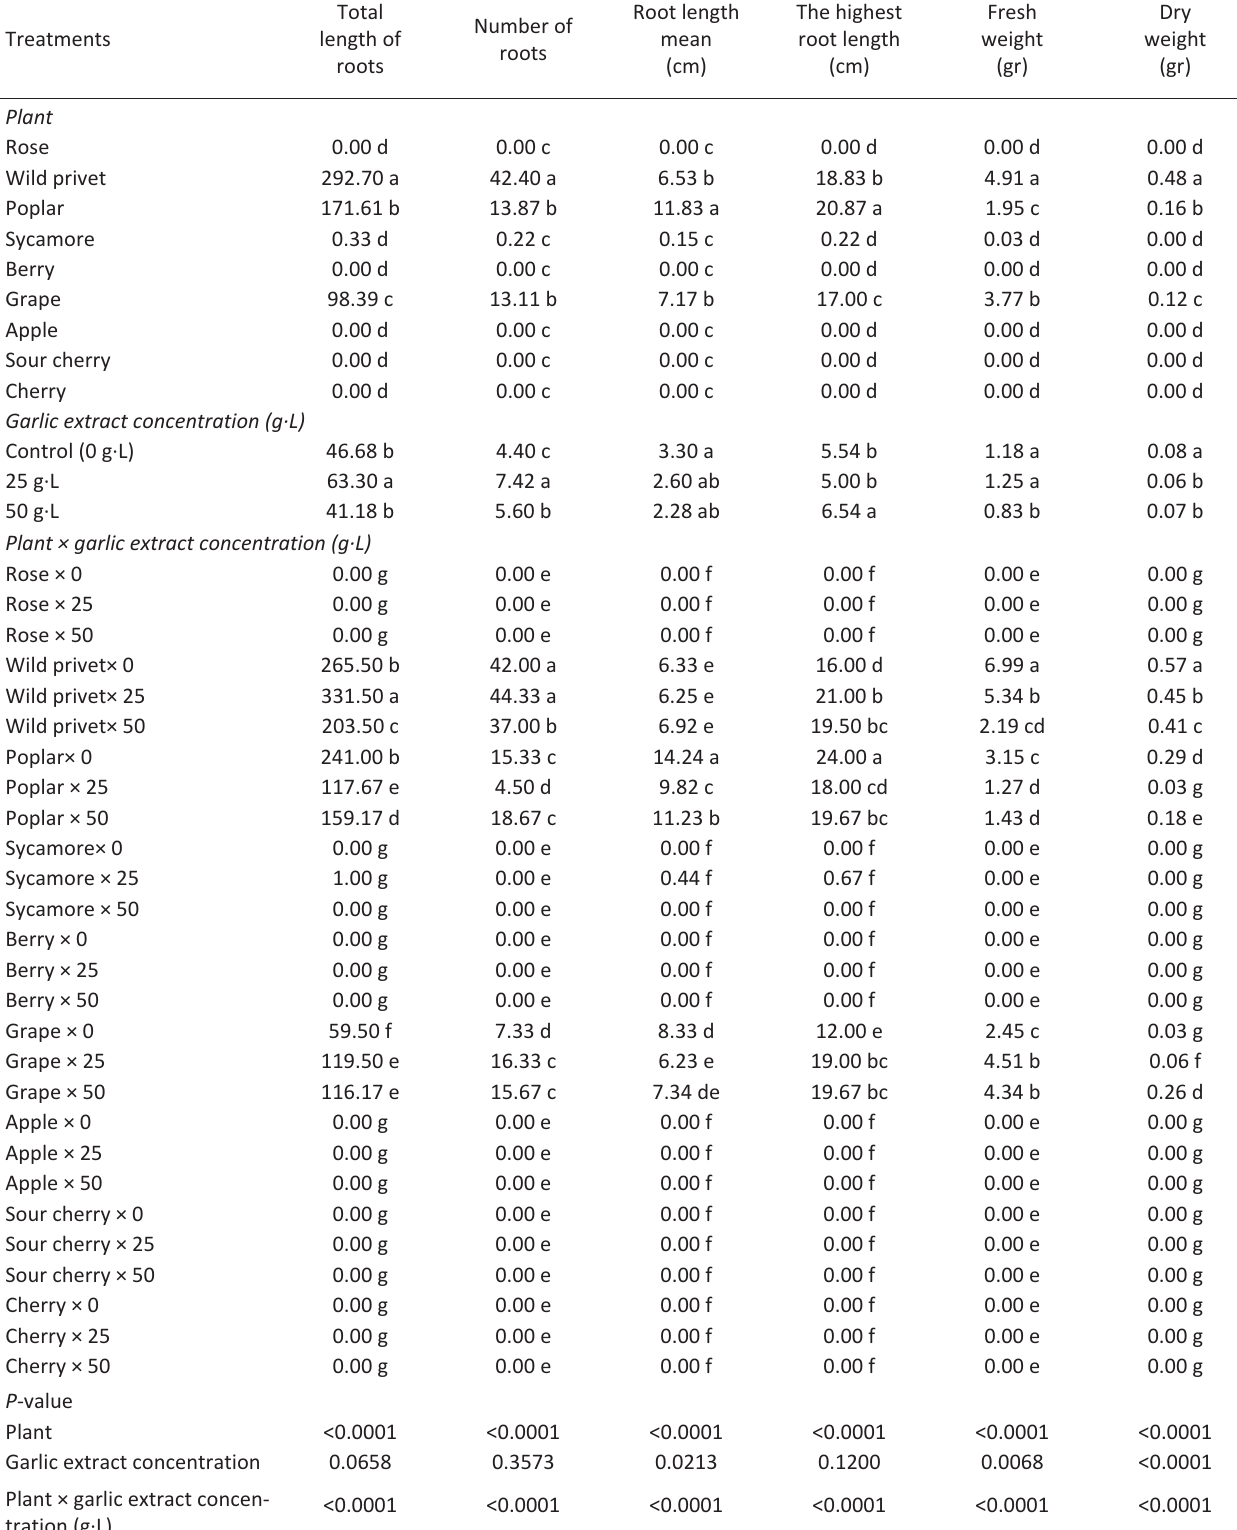
Mean values followed by the similar letters within a column are not significantly different from each other at P ≤0.05 (Duncan’s multiple range